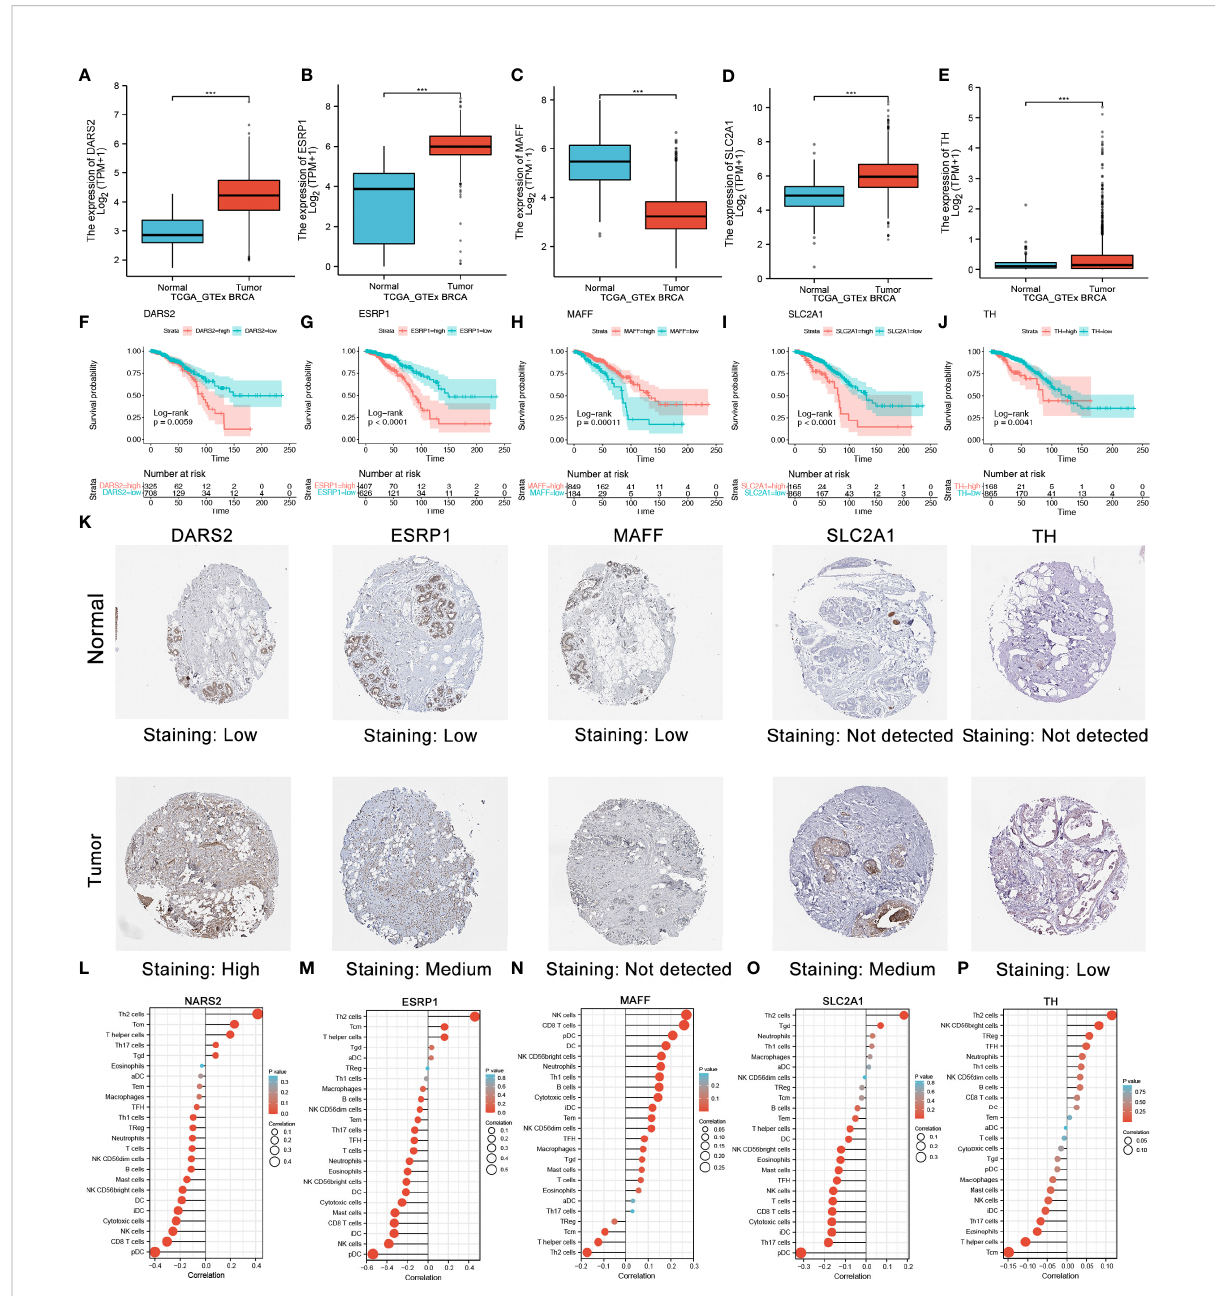
FIGURE 10 Validation of fi ve selected HLMRGs. (A – E) Comparisons of the fi ve HLMRGs between the BC and normal tissues combined with GTEx data. (F – J) Survival curve analysis of fi ve HLMRGs based on TCGA. (K) Immunohistochemical staining for fi ve HLMRGs in the normal breast tissue and BC. (L – P) Relationship between NARS2, ESRP1, MAFF, SLC2A1, and TH levels and immune cell in fi ltration based on ssGSEA. Statistical signi fi cance at the level of *** ≤